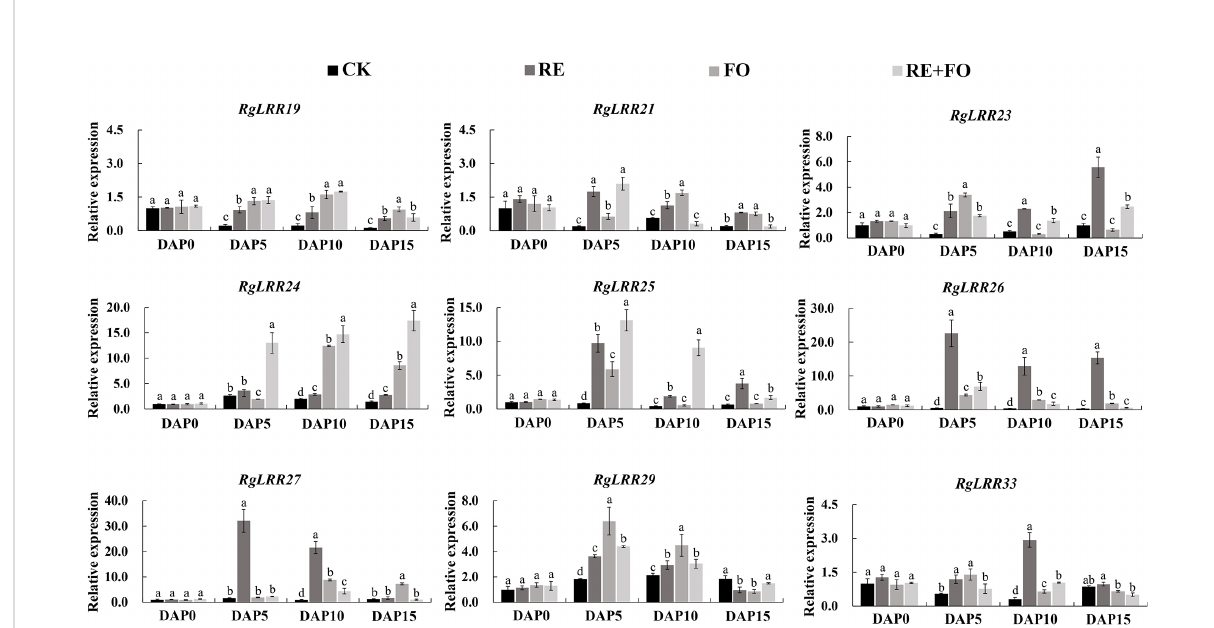
FIGURE 4 Expression patterns of crucial RgLRRs in Rehmannia glutinosa under the treatments of root exudates, F. oxysporum and comprehensive stress of root exudates and F. oxysporum . DAP, Days after planting; RE, the treatment of root exudates; FO, the treatment of F. oxysporum; RE+FO,the comprehensive treatment of root exudates and F. oxysporum. Different letters represent a signi fi cant difference at p <